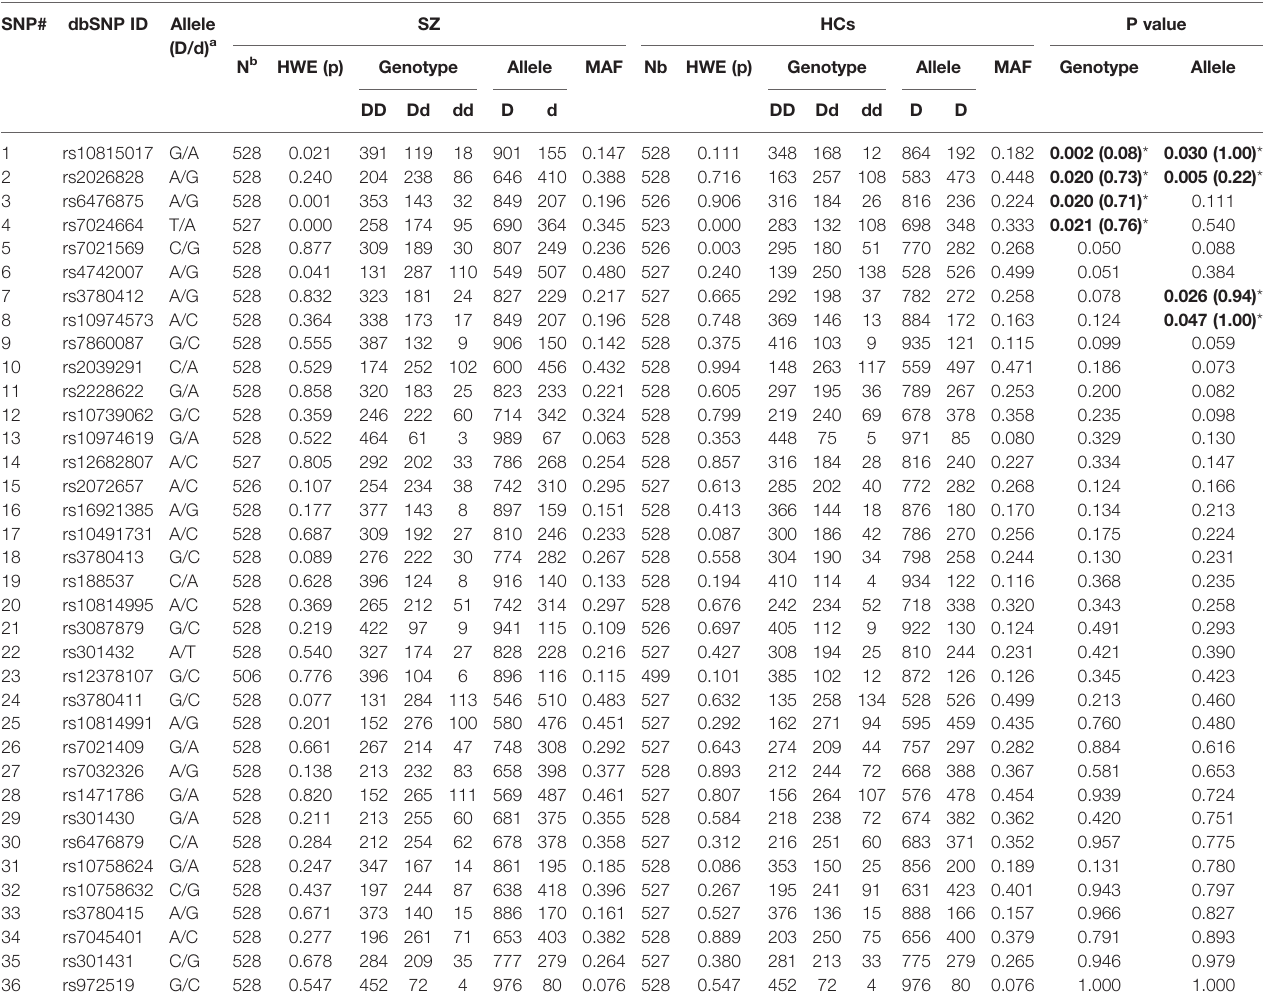
TABLE 2 | Genotype and allele frequencies of 36 SNPs in the SLC1A1 gene in SZ patients and healthy controls. SNP# dbSNP ID Allele (D/d)